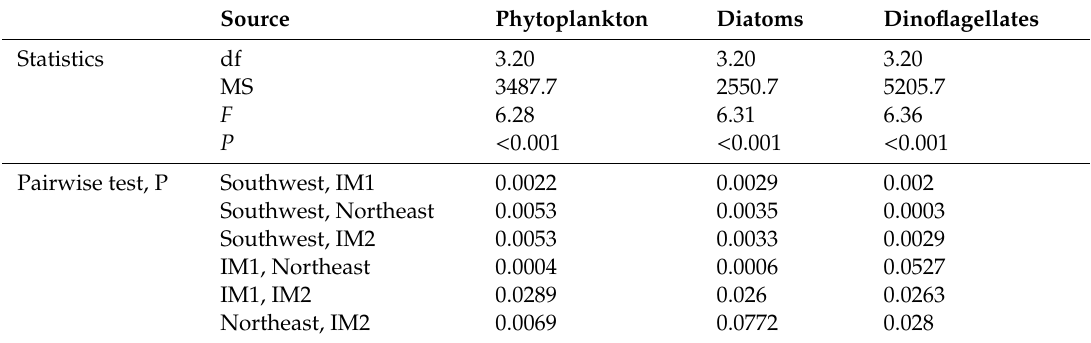
Table 4. PERMANOVA results contrasting phytoplankton communities among seasons in the Sangga Kechil estuarine-mangrove